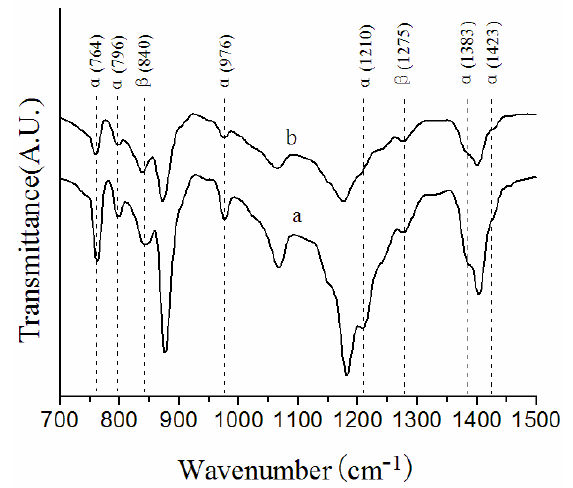
Figure 1. Fourier transform infrared spectroscopy-attenuated total reflectance (FTIR-ATR) spectra of ( a ) non solvent induced phase separation (NIPS) membrane; ( b ) melt spinning membrane.